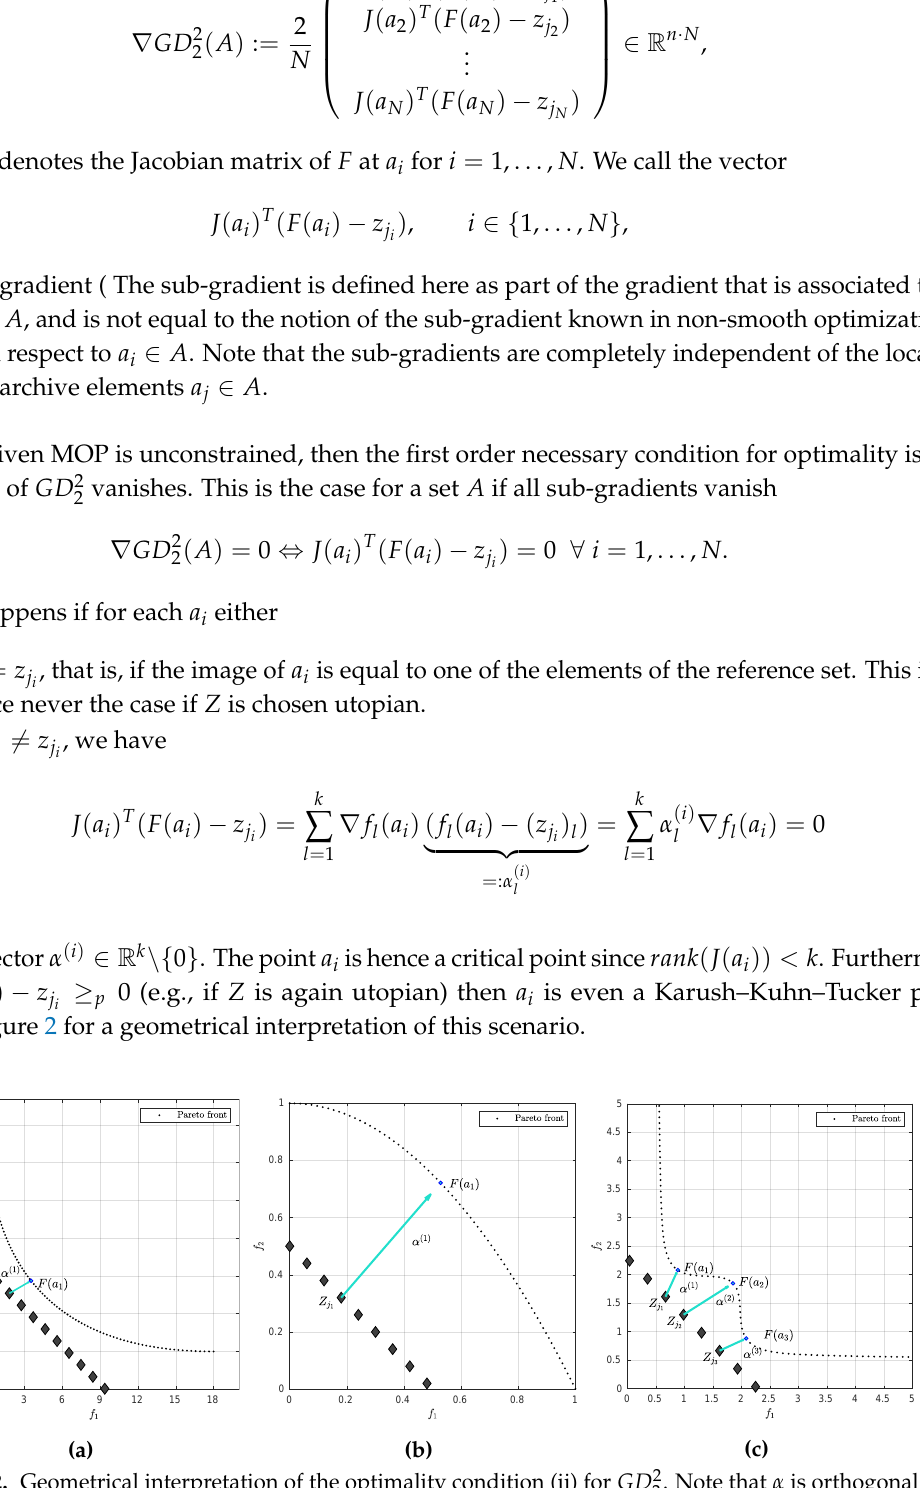
. Note that α is orthogonal 2